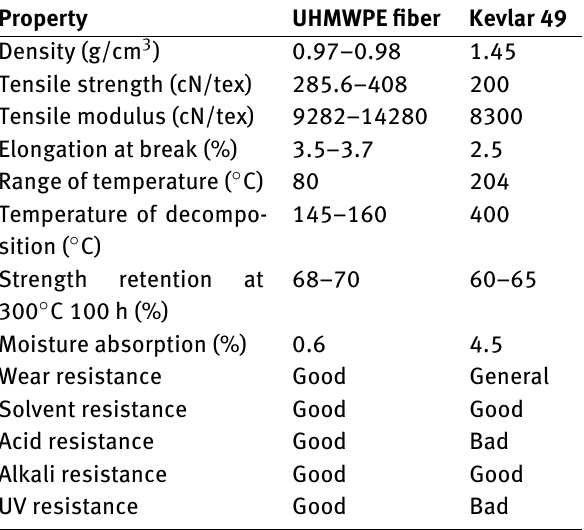
Table 1: Woven fabric Properties (UHMWPE and Kevlar 49) [23]